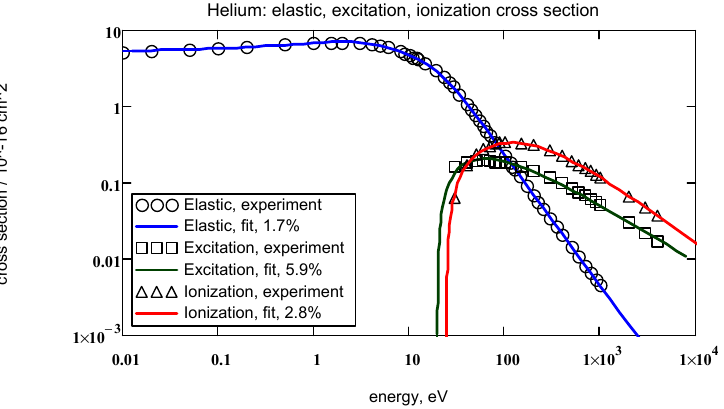
Figure 10. Elastic, excitation and ionization cross sections: experiments and the results of approx- imation for helium atoms.